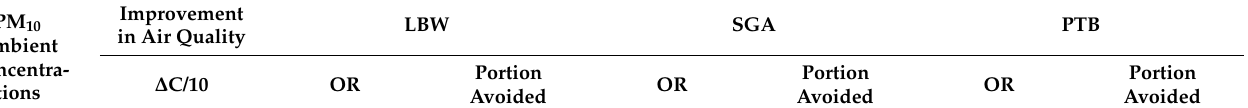
Table 5. Potential benefits of reducing annual PM 10 levels on birth